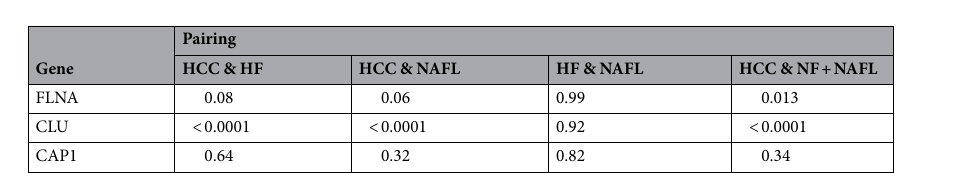
Table 4. Additional analysis. The table shown the statistically significance ( p -value) of all gene expression when pairing between HCC group, HF group, and NAFL group (all using t-test).